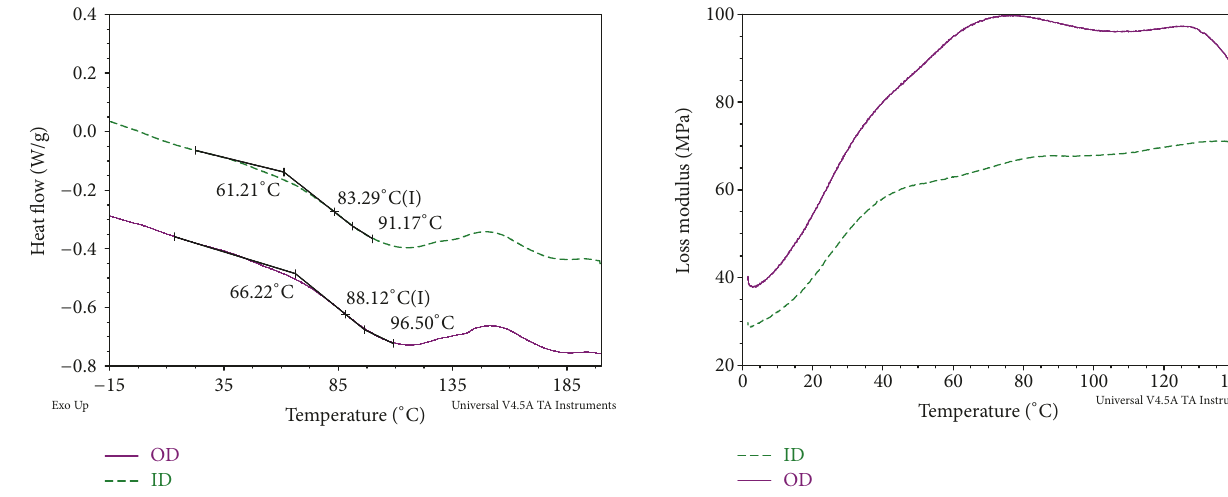
Figure 5: DSC analyses showing an endothermic transition of OD and ID films.